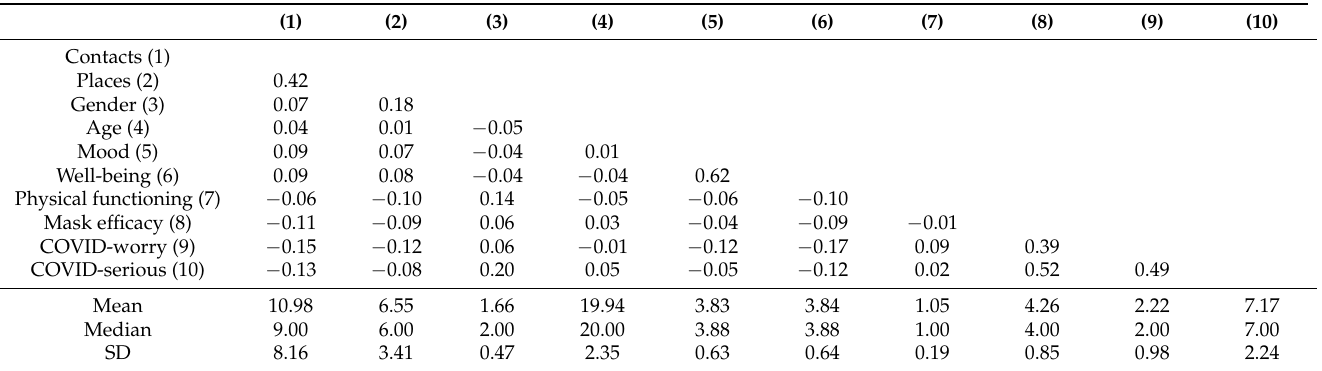
Table 1. Correlations and descriptive